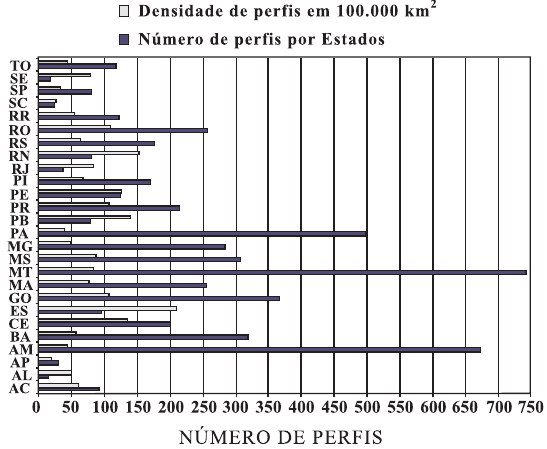
Figura 2. Representação gráfica do número e densidade de perfis de solo por Estado da